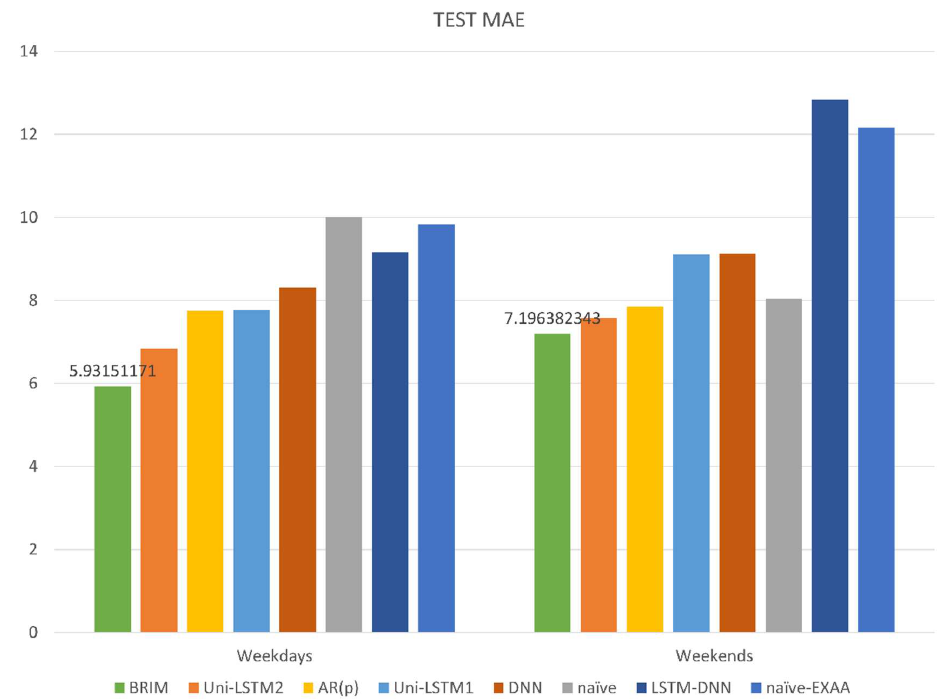
Figure 10. Comparison of predictive performance on weekdays and weekends by means of mean absolute error (MAE).